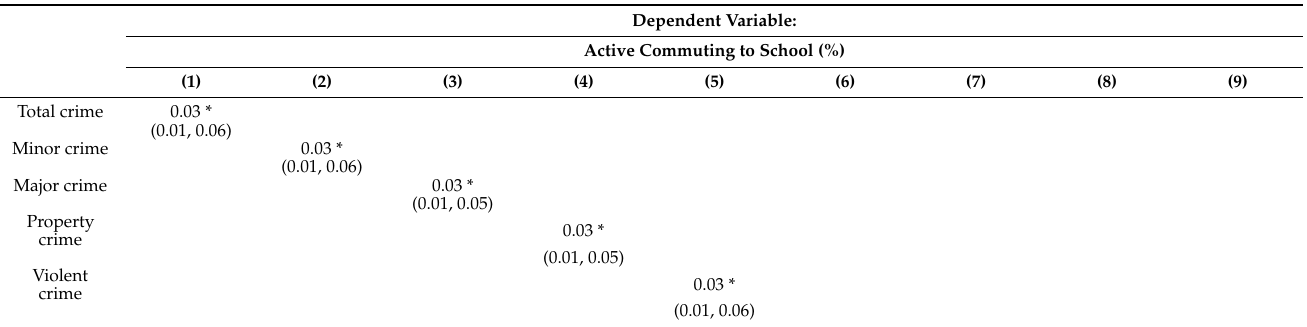
Table A1. Unadjusted models for police-reported crime types and